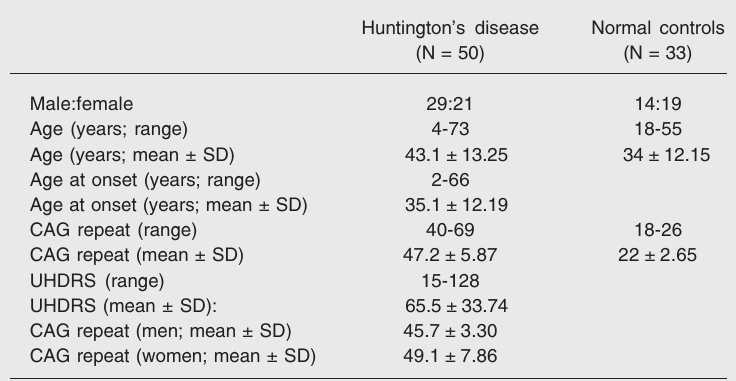
Table 1. Summary of clinical and molecular data in patients with Huntington’s disease and controls. Huntington’s disease Normal